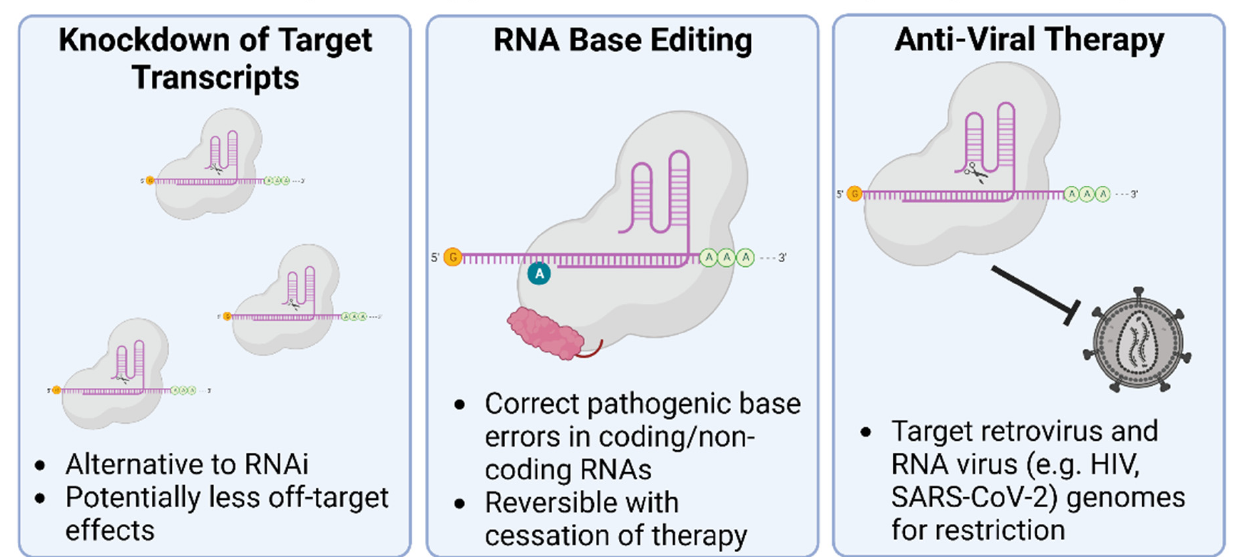
Figure 5. Emerging therapeutic applications for RNA editing by Cas